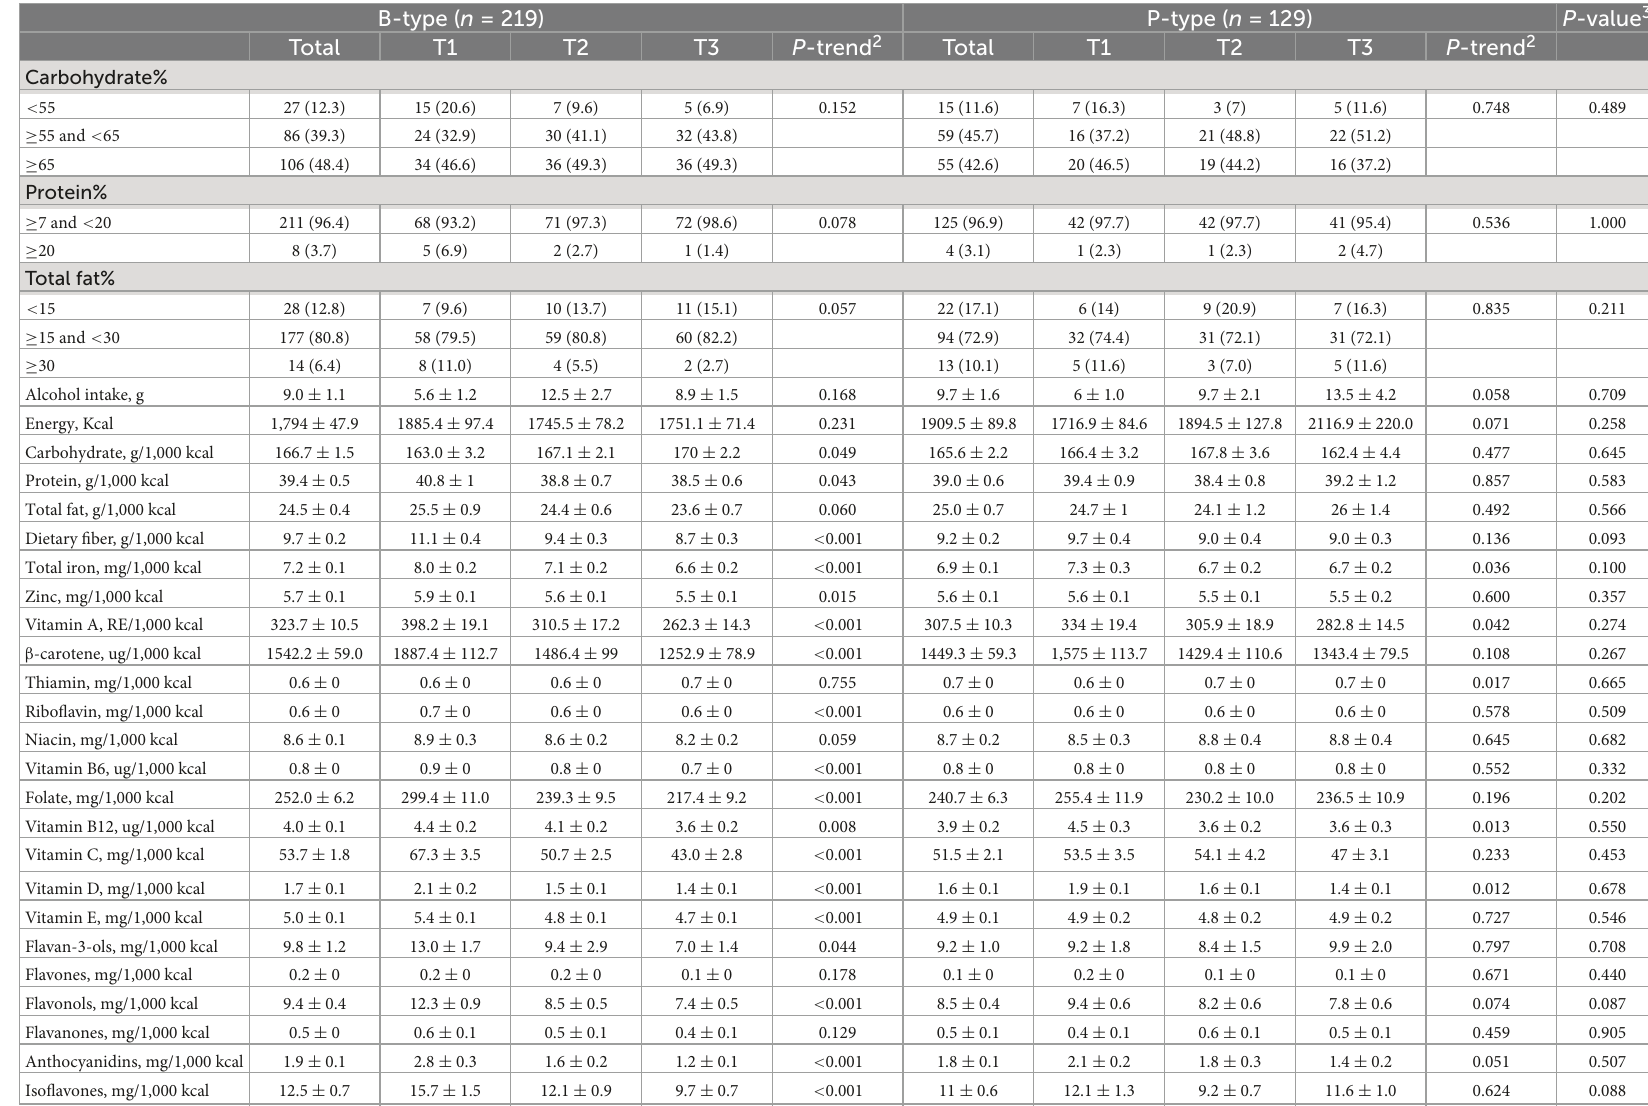
TABLE 4 Nutrient intakes across tertiles of dietary pattern scores by enterotypes 1